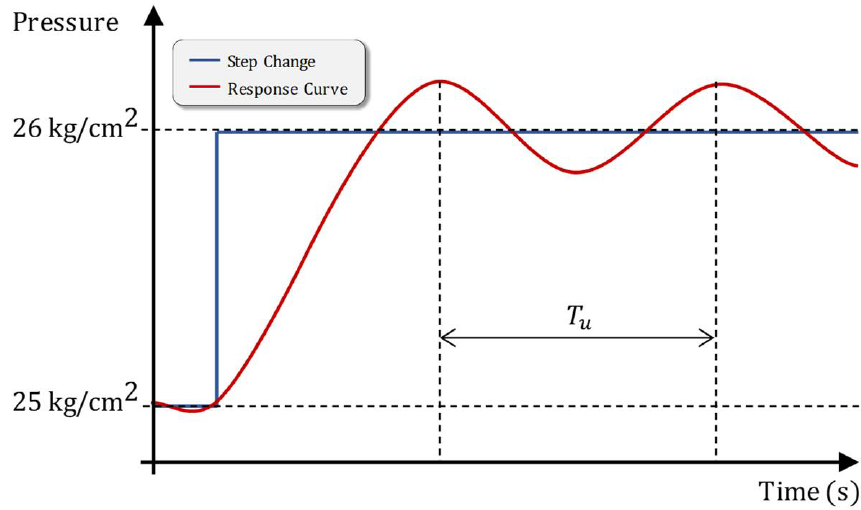
Figure 15. Block diagram of the PID controller principle.